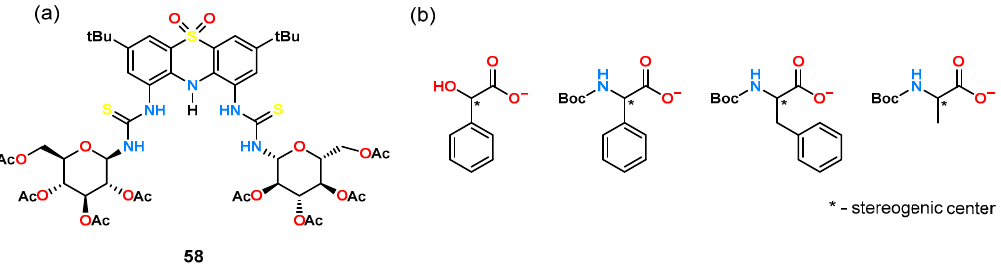
Table 2. Association constants of complexes for 57 with TBA salts of Boc-protected amino acids in acetonitrile (1:1 binding model).